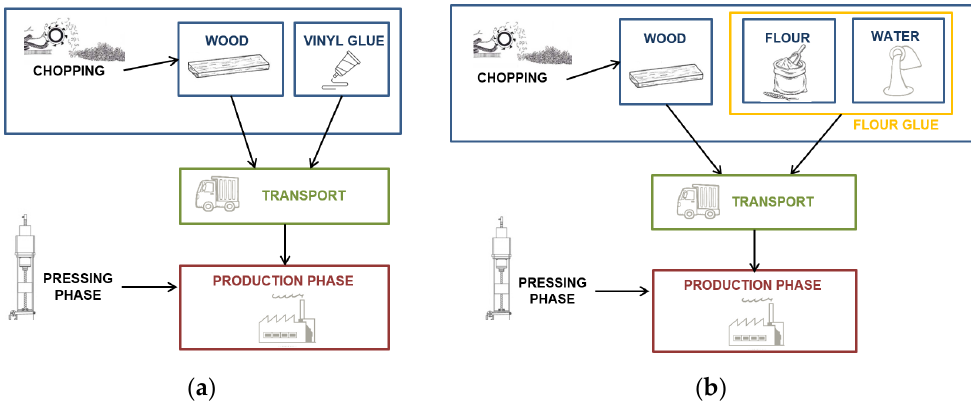
Figure 3. LCA analysis: flow charts of the panels fabrication: wood-based panel with vinyl glue ( a ); wood-based panel with flour glue ( b ).